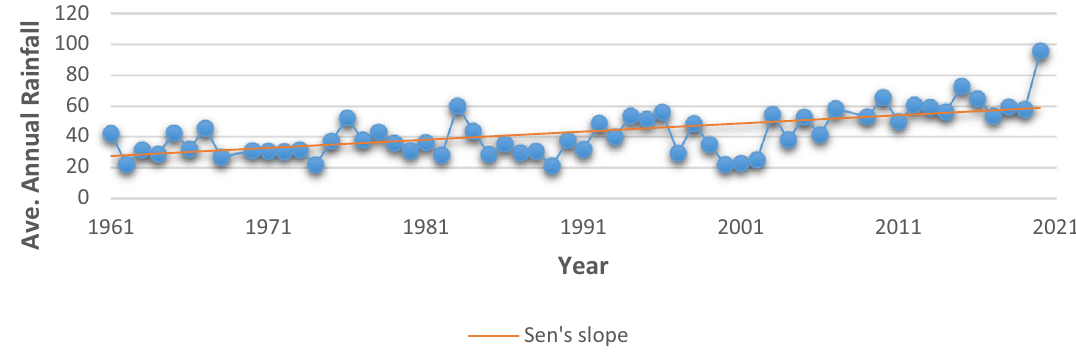
Fig. 2 A plot of average annual rainfall for Peshawar station. Data Source : Pakistan Meteorological Department and Regional Meteorologi- cal